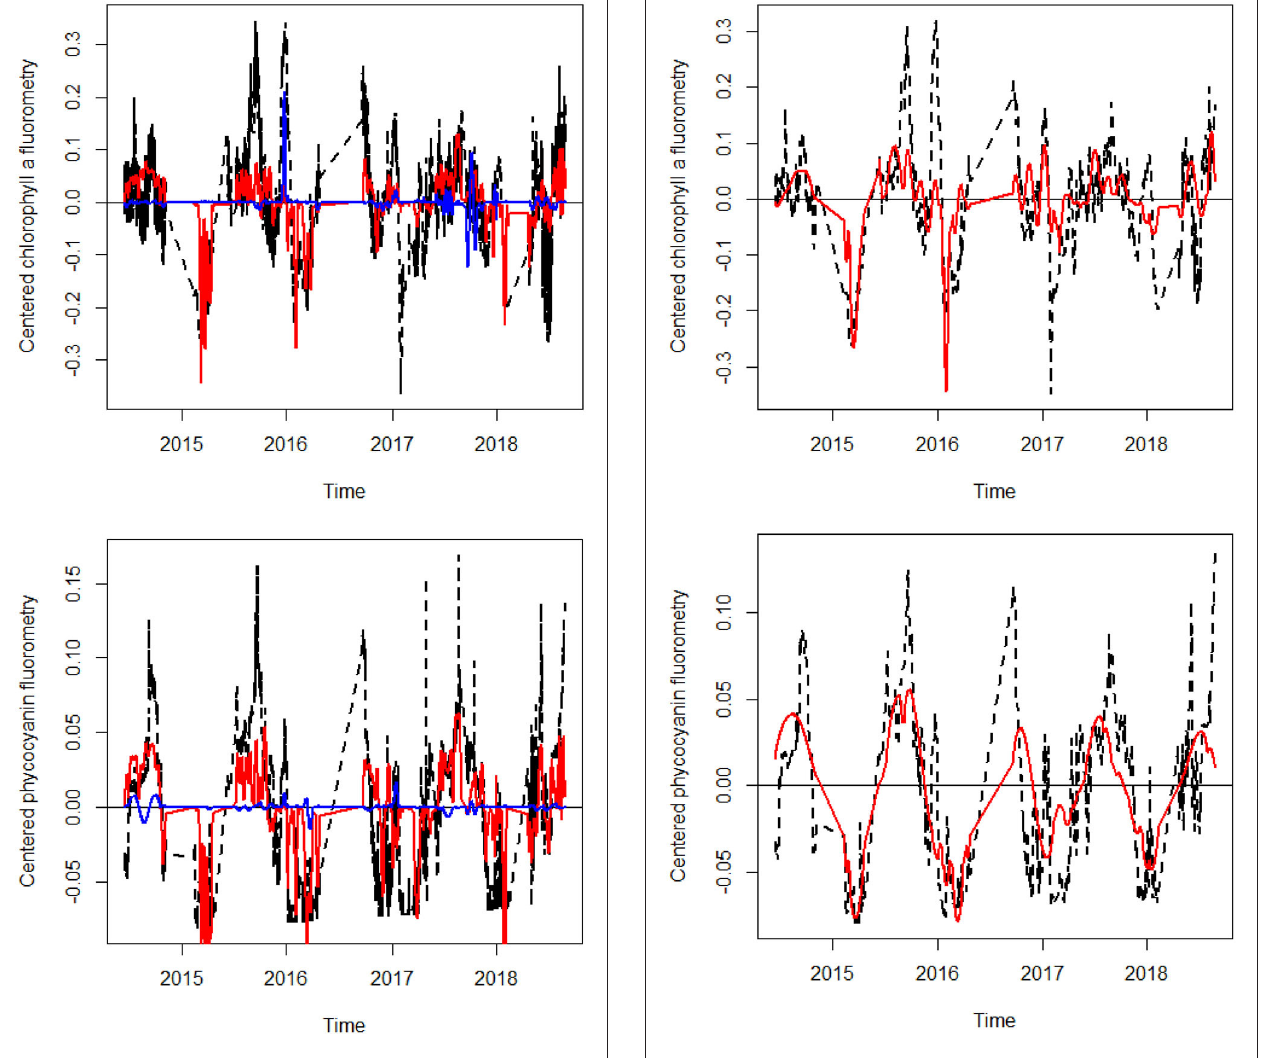
FIGURE 2 | Line plots of hourly chlorophyll a and phycocyanin flurorometry, along with their fitted values according to the sets of dbMEM variables related to water temperature. Observed values are in black, fitted values relating to dbMEM variables related to water temperature are in red.